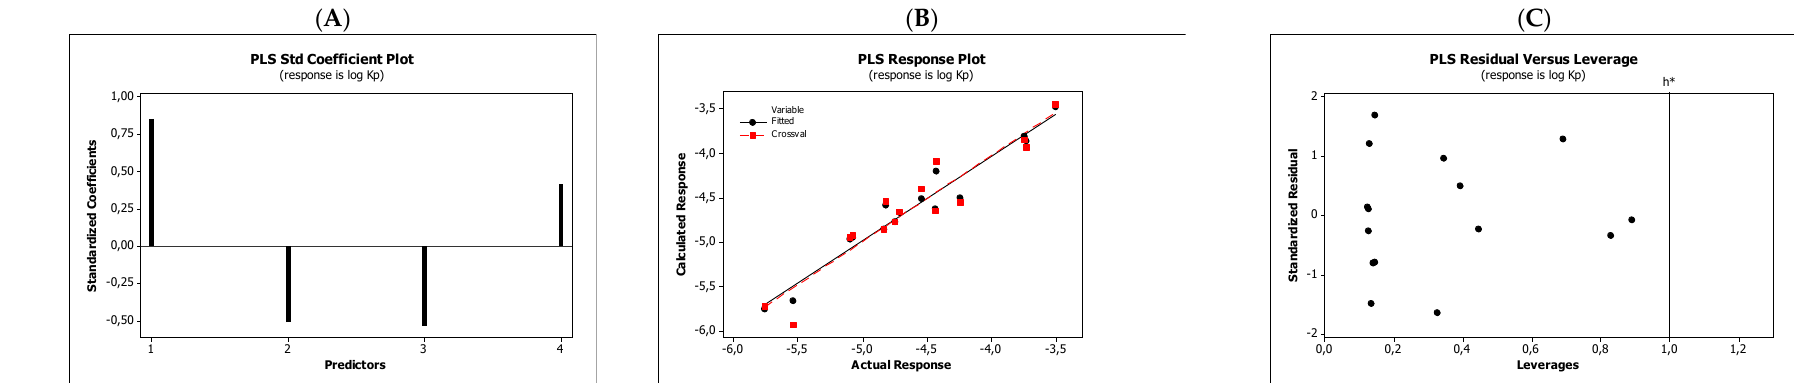
Figure 5. Standardized coefficients ( A ), the correlation between actual and predicted log K p parameters ( B ), and the Williams plots ( C ) of Equation (4).